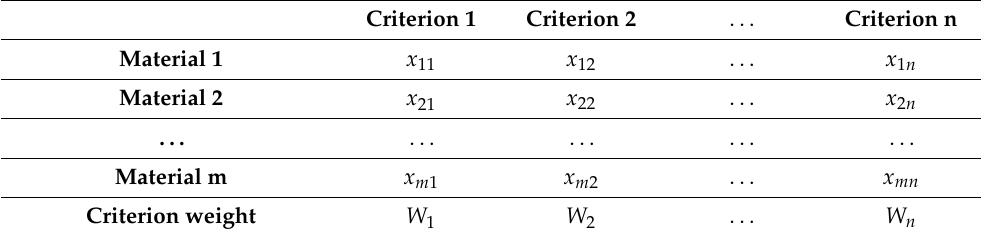
Table 4. Decision matrix and weights for each